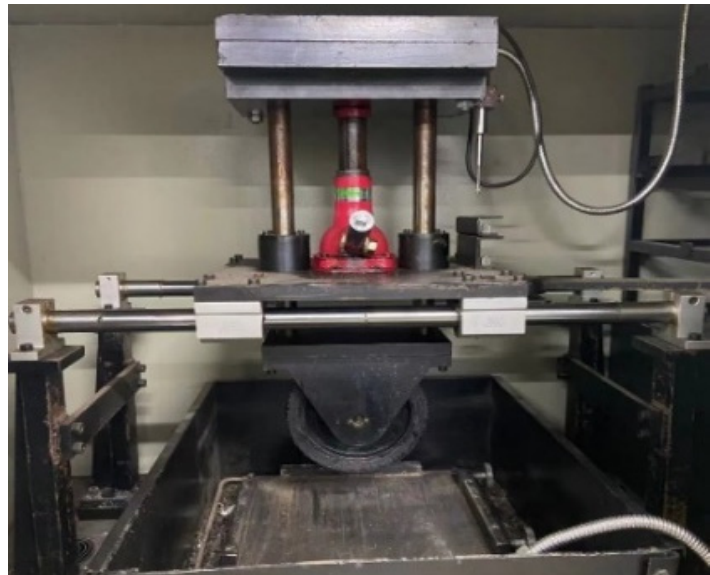
Figure 2. Rutmeter. Figure 2.